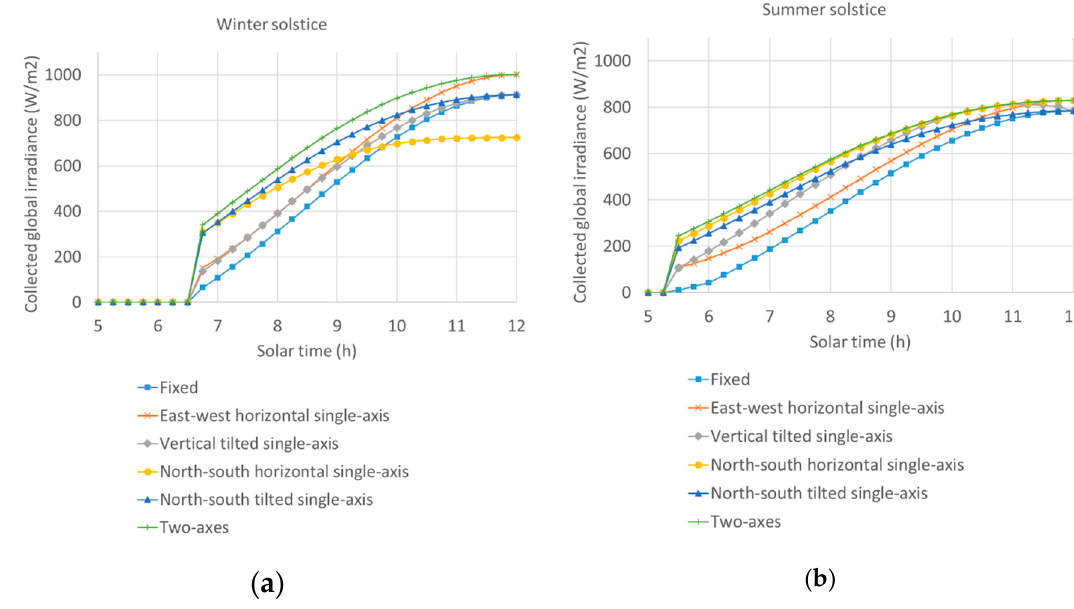
Figure 2. Ideal collected global irradiance of the different types of sun trackers over the winter ( a ) and summer ( b ) solstices in Aguascalientes, and comparison to a south-oriented fixed structure system with tilt equal to latitude. Table 1. Daily collected irradiation and percentage gains relative to a south-oriented fixed structure system with tilt equal to latitude of the different types of sun trackers for the winter and summer solstices in Aguascalientes.